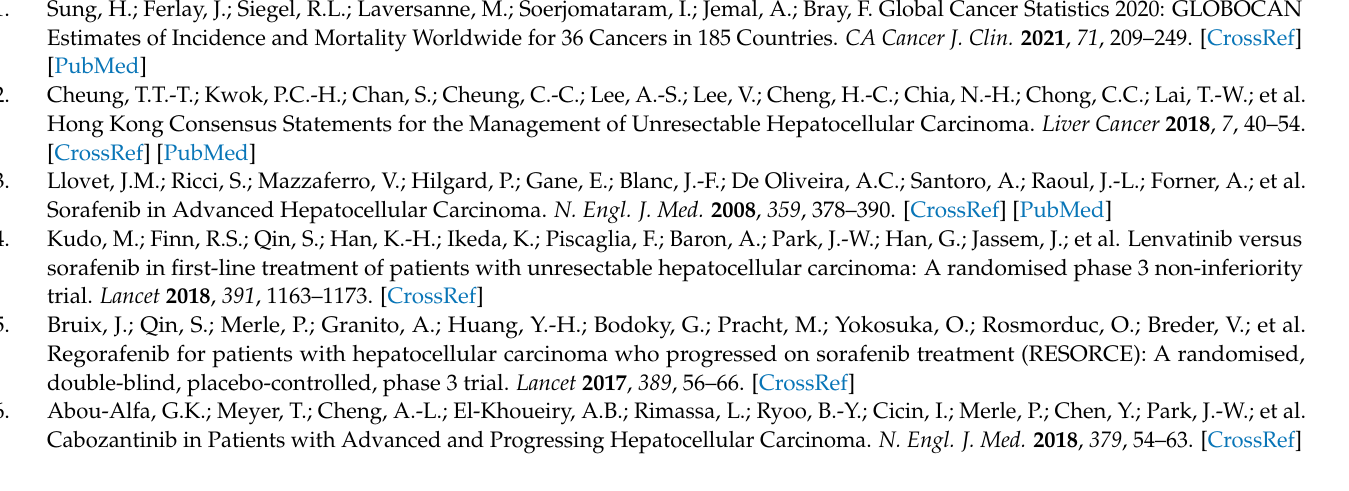
from Figure 1D, Figure S6: Uncropped Western Blot from Figure 2A, Figure S7: Uncropped Western Blot from Figure 3B, Figure S8: Uncropped Western Blot from Figure 6A, Figure S9: Uncropped Western Blot from Figure 7A, Figure S10: Uncropped Western Blot from Figure 7D, Figure S11: Uncropped Western Blot from Figure S2A, Figure S12: Uncropped Western Blot from Figure S3A, Table S1: Primer list, Table S2: Antibody list, Table S3: Correlation between MAEL expression and clinicopathological in TCGA-LIHC